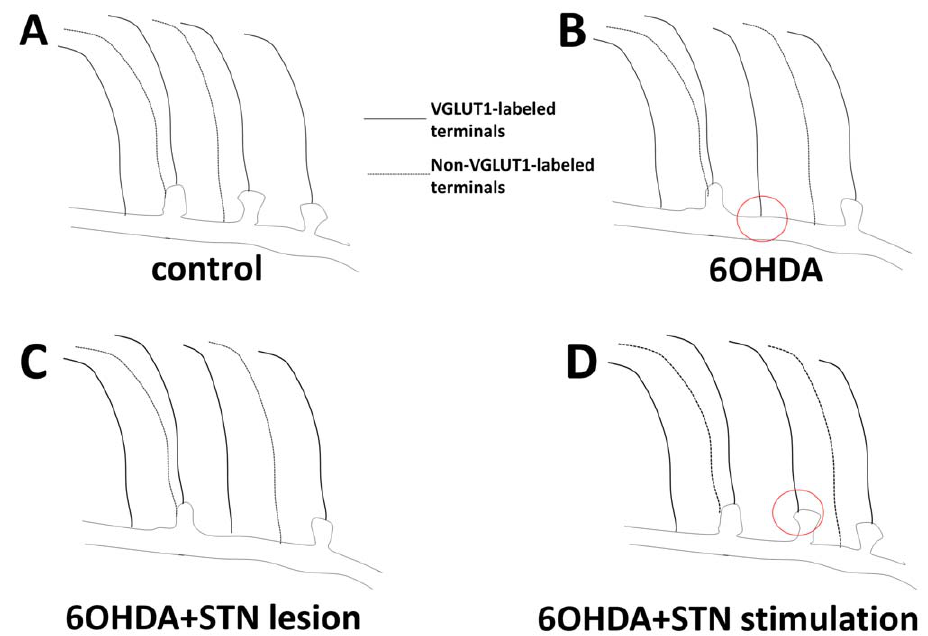
Figure 6. Summary of findings. Compared with control (A), in 6OHDA-lesioned rats, there were relatively more VGLUT-1 labeled terminals making synapses upon the shafts of dendrites (red circle; B). We hypothesise that this is due to fewer spines being available. There was no change in density of glutamate labeling. With STN lesions, there was decreased glutamate labeling in VGLUT1-labeled terminals, indicating increased release, indicated here by increased line thickness (C). With STN stimulation, there was decreased glutamate labeling, suggesting increased release in both types of terminals, and an increase in the proportion of VGLUT1-labeled terminals upon spines (red circle; D). We did not count spines, but postulate that there were more spines available for synapses due to plasticity. The relative numbers of VGLUT1-labeled and –unlabeled terminals and their locations are not accurate.